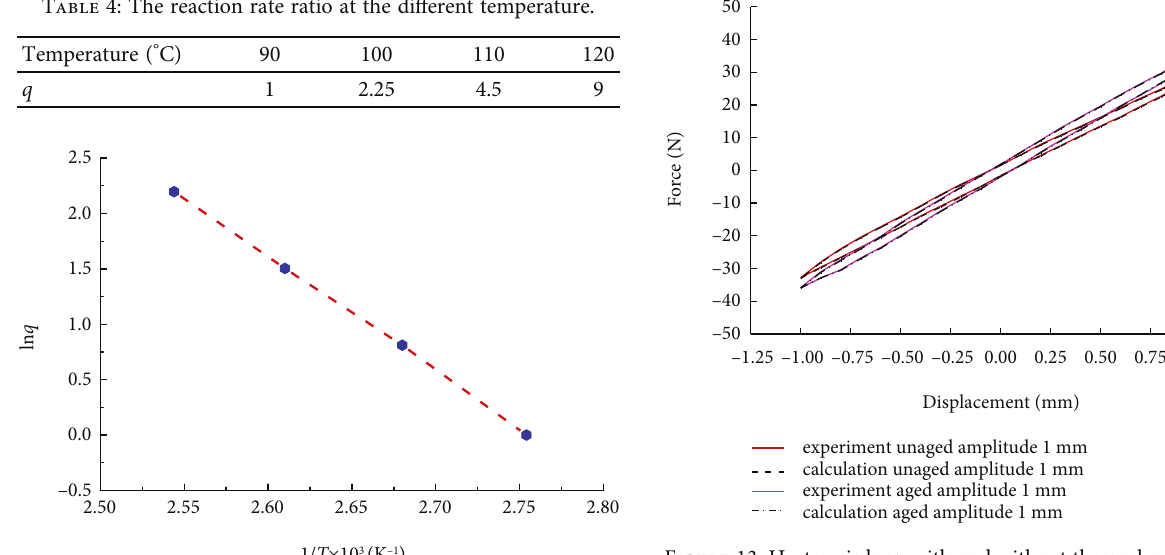
Figure 13: Hysteresis loop with and without thermal oxygen aging (excitation amplitude 1mm). Table 6: Model Parameters of the SCFM and the